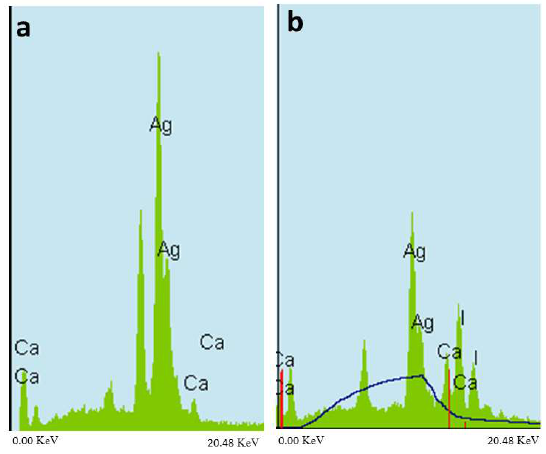
Figure 8. Energy dispersive X-ray spectroscopy (EDS) analysis: ( a ) SDF and SDF + GSH group and ( b ) SDF + KI group.